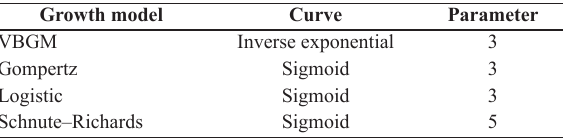
Table 1. Candidate growth models to describe trend age- length data for Pacific hake, Merluccius productus , in the Gulf of California. Curve Parameter Inverse exponential Sigmoid Sigmoid Schnute–Richards Sigmoid 5 VBGM = von-Bertalanffy growth